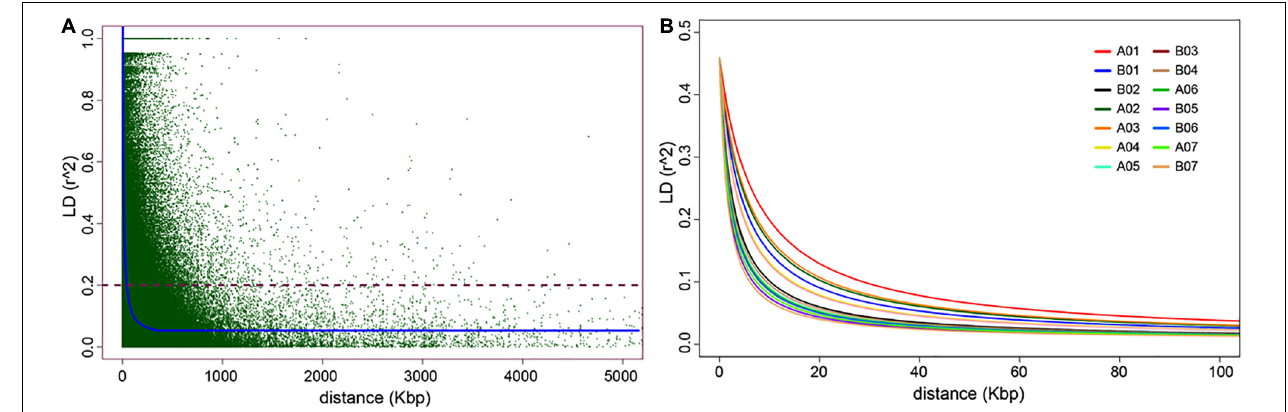
FIGURE 3 | Genome-wide linkage disequilibrium (LD) decay plots. In (A) , the average genome-wide LD-decay against the genomic distance (kbp). In (B) , the LD-decay per assembled chromosome